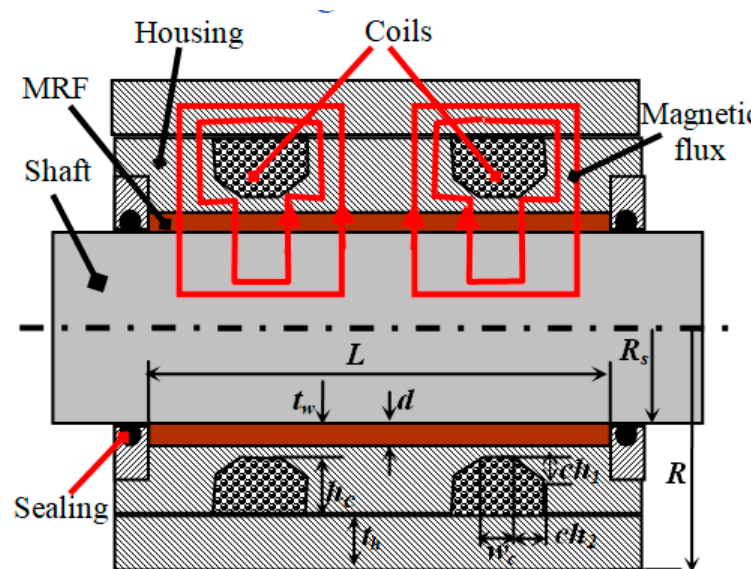
Figure 8. Configuration of the linear MR brake.